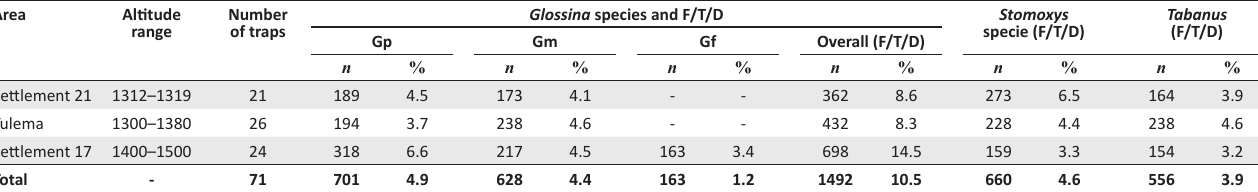
TABLE 1: Relative abundance of Glossina species and biting flies trapped from three settlement areas. Area Altitude Number range of traps